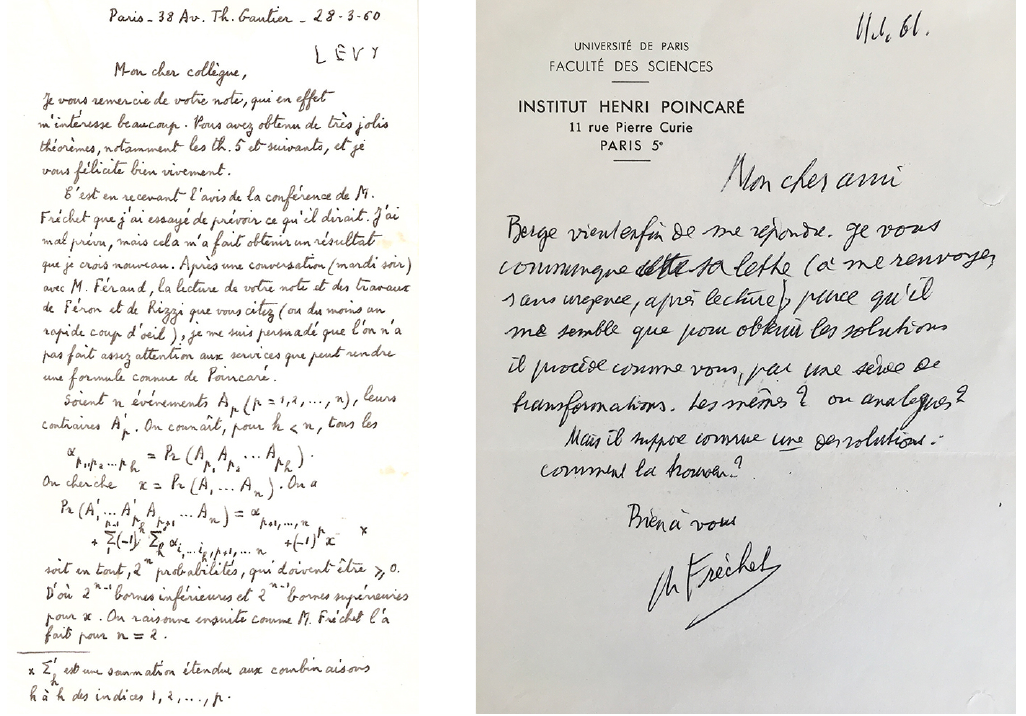
Figure 5: A letter from Paul Lévy (left) and a letter from Maurice Fréchet (right) as received by Giorgio Dall’Aglio in 1960 and, respectively,